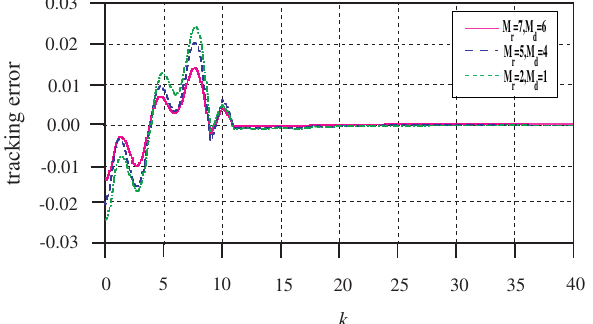
Figure 4. The tracking errors with different preview length.